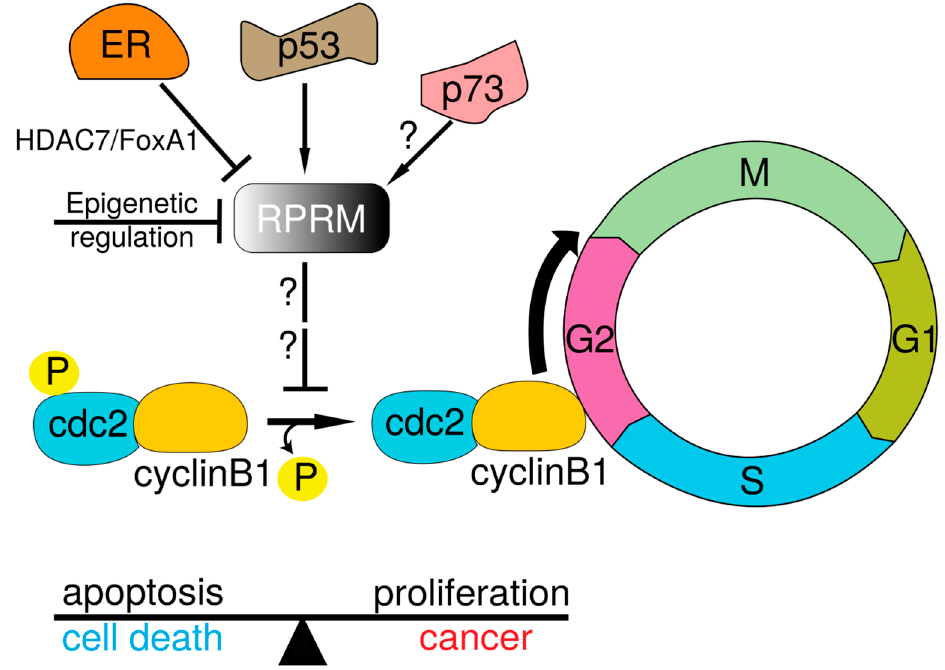
Figure 4. Schematic model of RPRM-mediated cell cycle and G2 arrest mechanisms. RPRM has been identified as a transcriptional target for: (1) p53 [4]; (2) histone deacetylase 7/FoxA1 (HDAC7/FoxA1) in an estrogen mediated mechanism [49]; and (3) for epigenetic silencing by hypermethylation of its promoter region [54]. A potential regulation by p73 it has also been proposed [3]. RPRM expression results in inhibited dephosphorylation of Cdc2, suppressing the activation of the Cdc2-Cyclin B1 complex. Thus, inducing cell cycle arrest at G2 suggesting a potential role for RPRM as a tumor suppressor gene [4]. The balance towards cell cycle arrest or proliferation can be shifted by multiple antagonistic effectors, amongst them RPRM . Straight lines with arrowheads indicate activation. Lines with no arrowhead indicate inhibition. Curved arrow on the bottom left indicates dephosphorylation of Cdc2/Cyclin B1 complex. Curved thick arrow on the bottom right indicates nuclear translocation of dephosphorylated Cdc2/Cyclin B1 at the G2/M checkpoint.